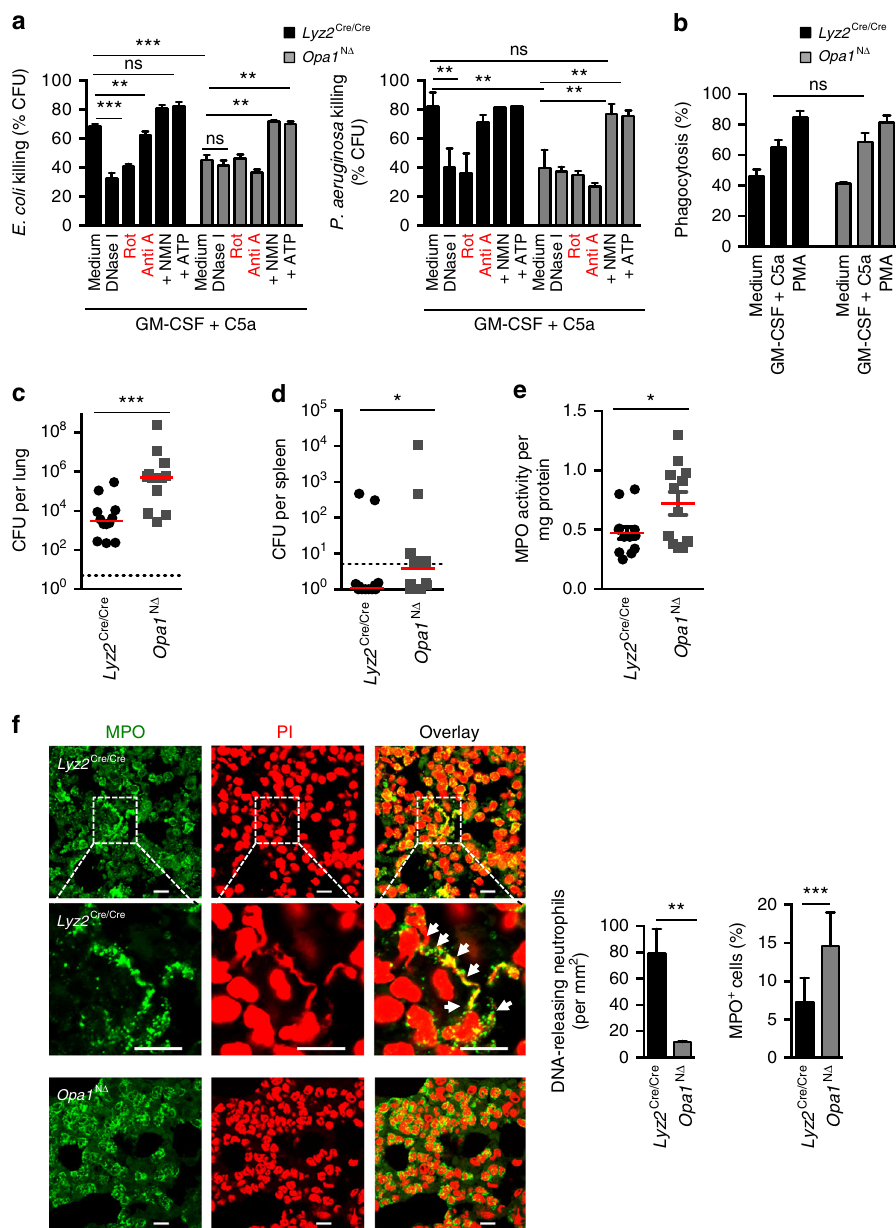
Fig. 7 Anti-microbial response of Opa1 N Δ neutrophils and failure to clear P. aeruginosa lung infections. a Bacterial killing assays. Neutrophils of Opa1 N Δ and control mice were primed with GM-CSF and subsequently stimulated with C5a before co-culture with E. coli – GFP (left panel) and P. aeruginosa (right panel) in presence or absence of the indicated inhibitors or following 100 μ M ATP or 500 μ M NMN pre-treatment. Values are means ± SEM. n.s., not signi fi cant; ** p < 0.01; *** p < 0.001; n = 4. b Phagocytosis assay. Phagocytosis of opsonized E. coli -GFP by Opa1 N Δ and control neutrophils was analyzed after 35 min. Values are means ± SEM ( n = 3); n.s., not signi fi cant. c , d Bacterial clearance in vivo. Opa1 N Δ and control mice were intra-nasally inoculated with 2 × 10 6 CFUs of P. aeruginosa . Total CFU numbers of bacteria were assessed by plating homogenized lungs ( c ) and spleen ( d ) on agar plates. The medians are indicated and each symbol represents a value for an individual mouse. * p < 0.05; *** p < 0.001. e MPO enzymatic activity assay. Neutrophil in fi ltration of lungs in Opa1 N Δ and control mice was assessed by MPO activity in total lung homogenates. The medians are indicated and each symbol represents a value for an individual mouse. * p < 0.05. f Confocal microscopy. Lung sections of Opa1 N Δ and control mice were obtained after infection with P . aeruginosa and stained with anti-MPO antibody (green) and PI (red). Higher magni fi cations are shown in the middle panels; white arrows indicate co-localization of extracellular DNA and MPO. Bars, 10 µ m. Right: quanti fi cation of the DNA-releasing and in fi ltrating neutrophils in the lungs. Quanti fi cation of MPO positive in fi ltrating neutrophils compared with total PI positive nuclei in the infected lungs using an automated slide scanner. Values are means ± SEM. ** p < 0.01; *** p < 0.001; n =